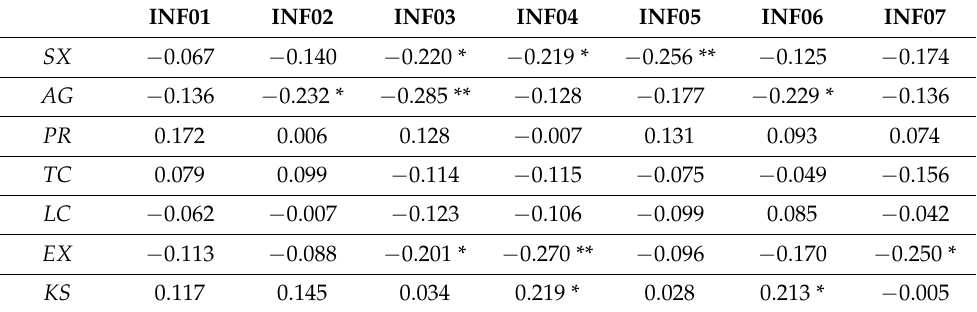
Table A3. Spearman correlation matrix: knowledge of information access and management tools.